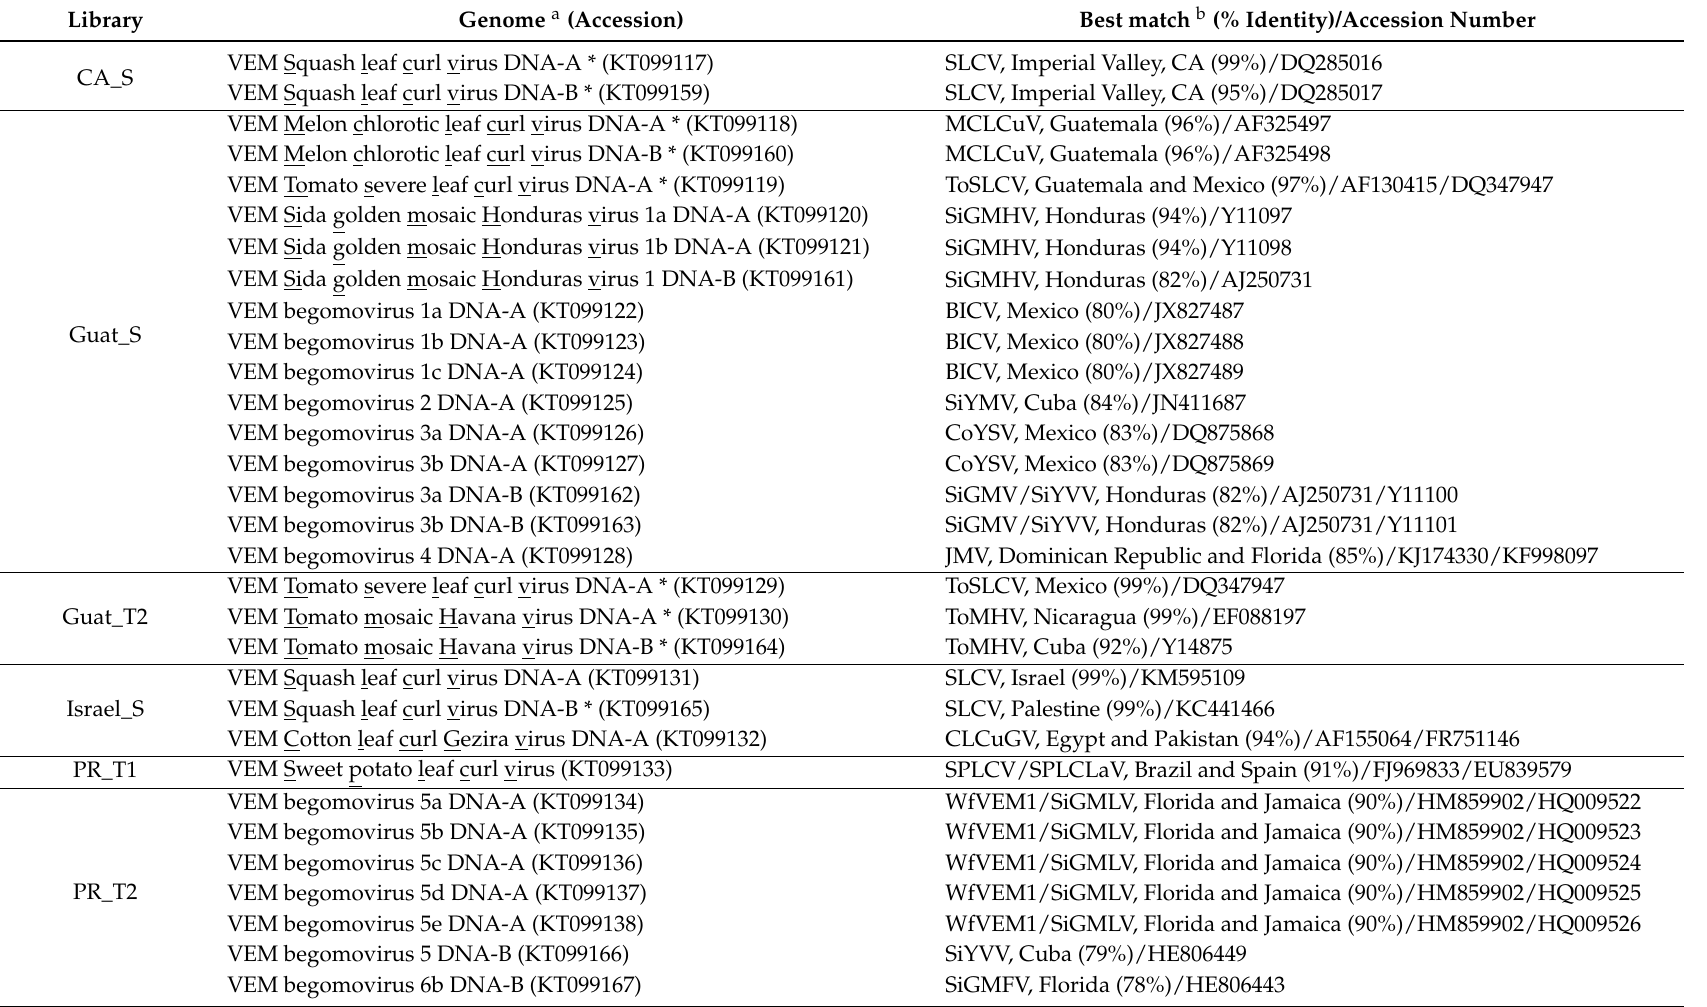
Table 2. Begomovirus genomes identified in